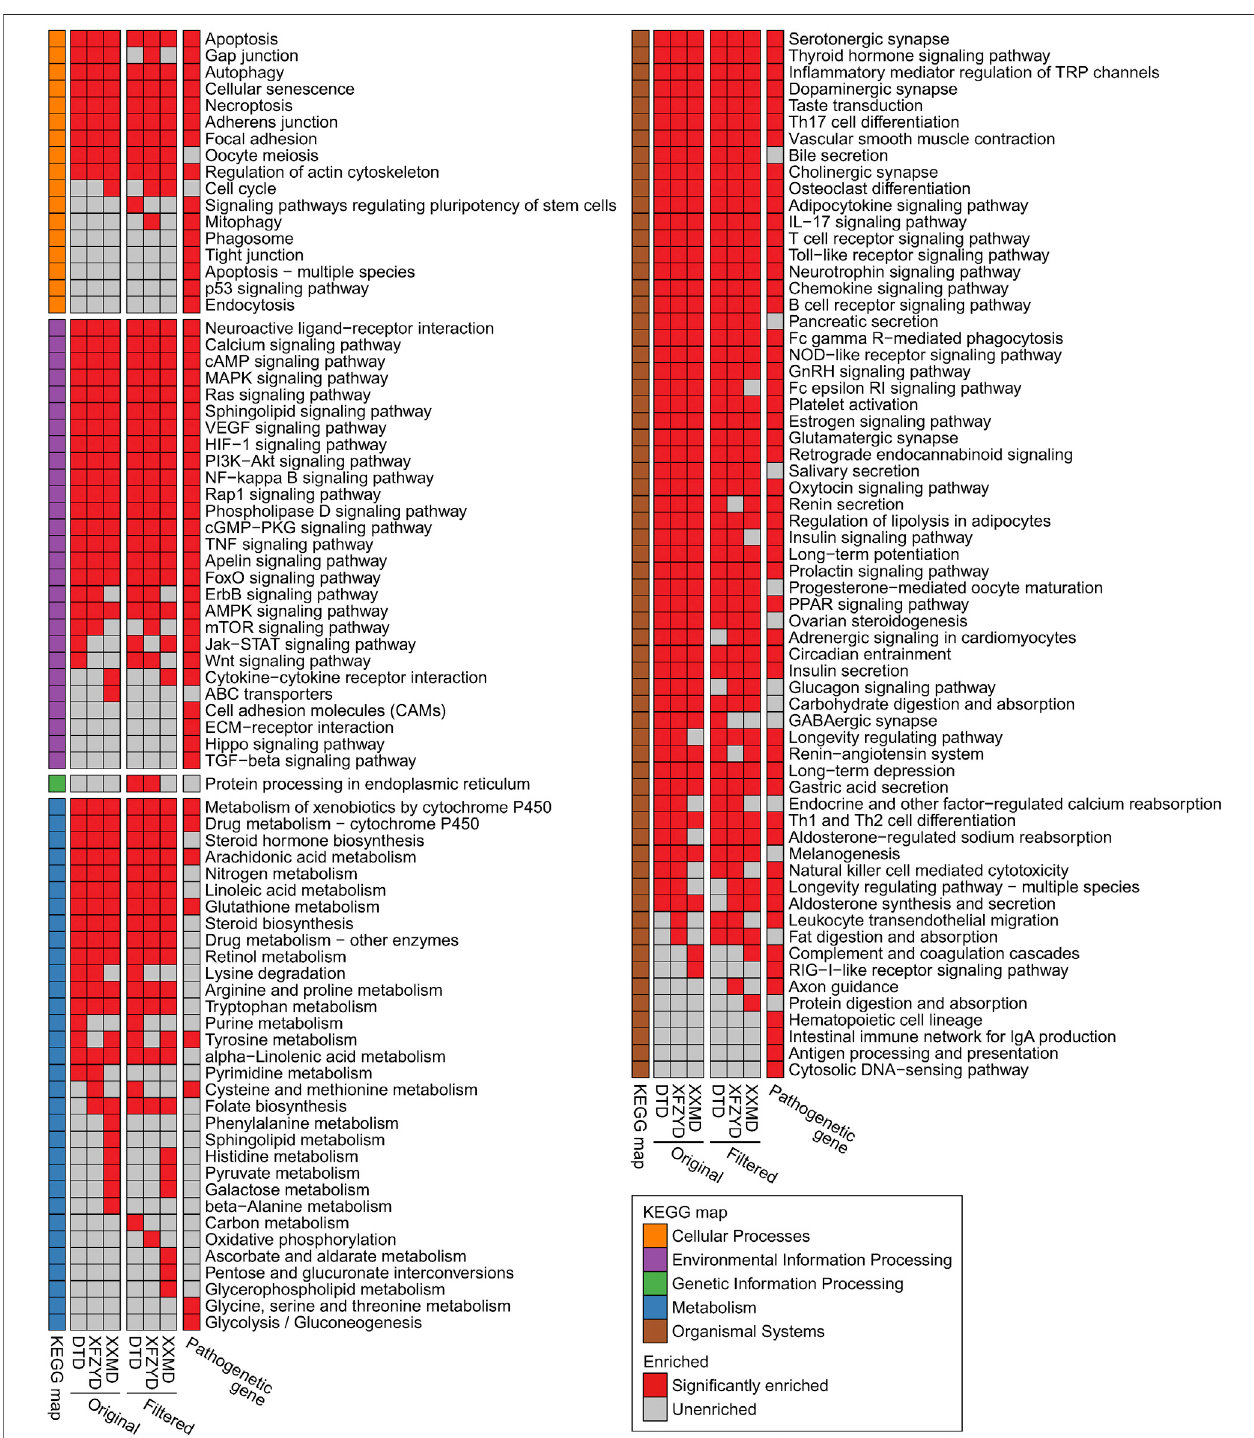
FIGURE 4 | The enriched KEGG pathways of pathological genes and the original and fi ltered target genes of DTD, XFZYD, and XXMD: The fi gure shows the union set of the top 100 enriched KEGG pathways (sorted by FDR corrected p value) in each group.